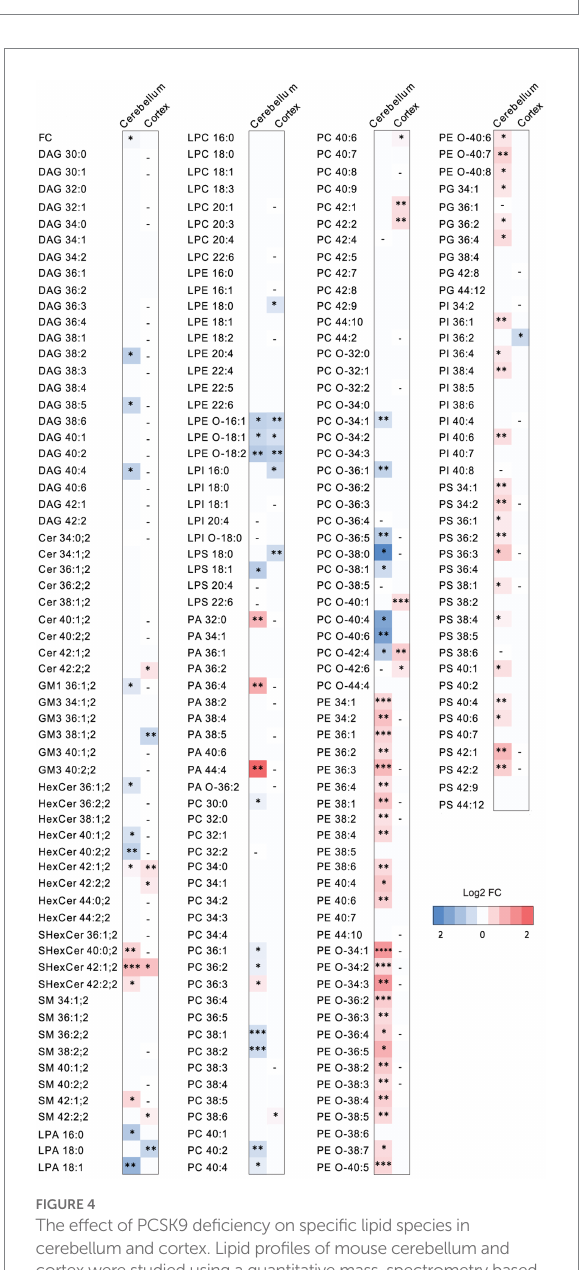
FIGURE 4 The effect of PCSK9 deficiency on specific lipid species in cerebellum and cortex. Lipid profiles of mouse cerebellum and cortex were studied using a quantitative mass-spectrometry based shotgun lipidomics method. Heatmap of lipid species in PCSK9 KO cortex and cerebellum in mol % compared to WT, shown as log2 fold changes. N = 9 per group; 13-to 15-week-old male mice. Only statistically significant results showed. Statistical significance was assessed using unpaired two-tailed Student’s t test, alpha = 0.05. See also Supplementary Tables S2, S3 for descriptive statistics and individual p values. Asterisks indicate significantly different values (* p ≤ 0.05; ** p ≤ 0.01; *** p ≤ 0.001; **** p ≤ 0.0001). Dash indicates the absence of the lipid species in the brain area.